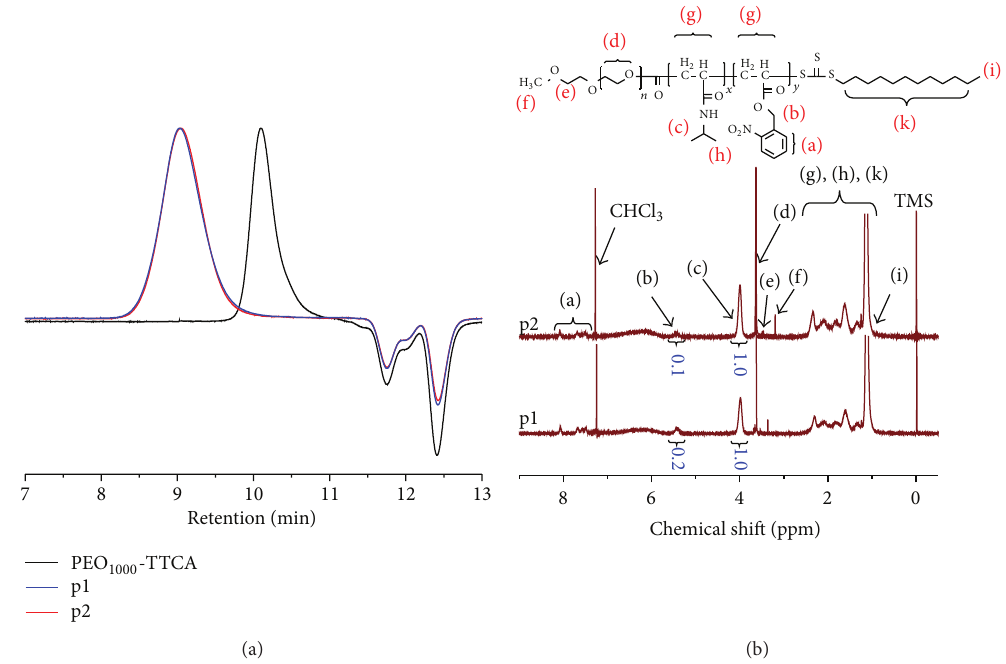
Figure 1: (a) GPC curves of PEO macroinitiator and the two block copolymers with different NBA moieties; (b) 1 H NMR (in CDCl 3 ) spectra of p1 and p2.